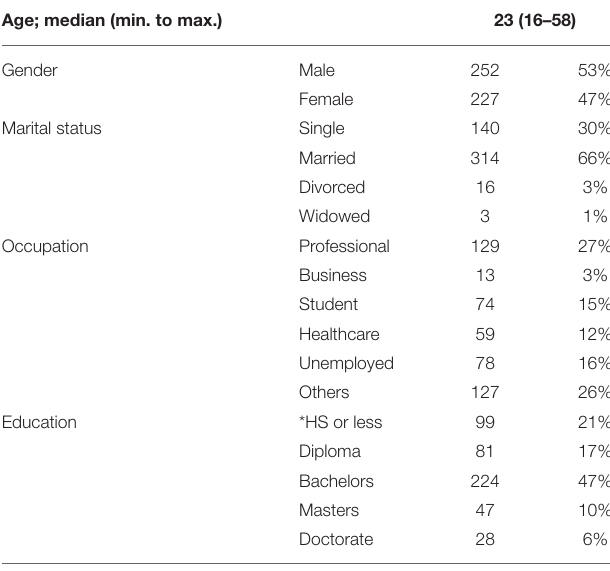
TABLE 1 | Subject characteristics ( N =